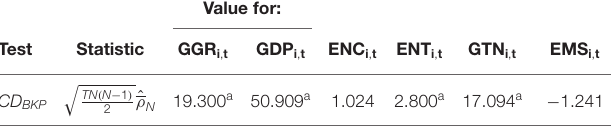
TABLE 4 | Tests for cross-sectional dependence in variables. Value